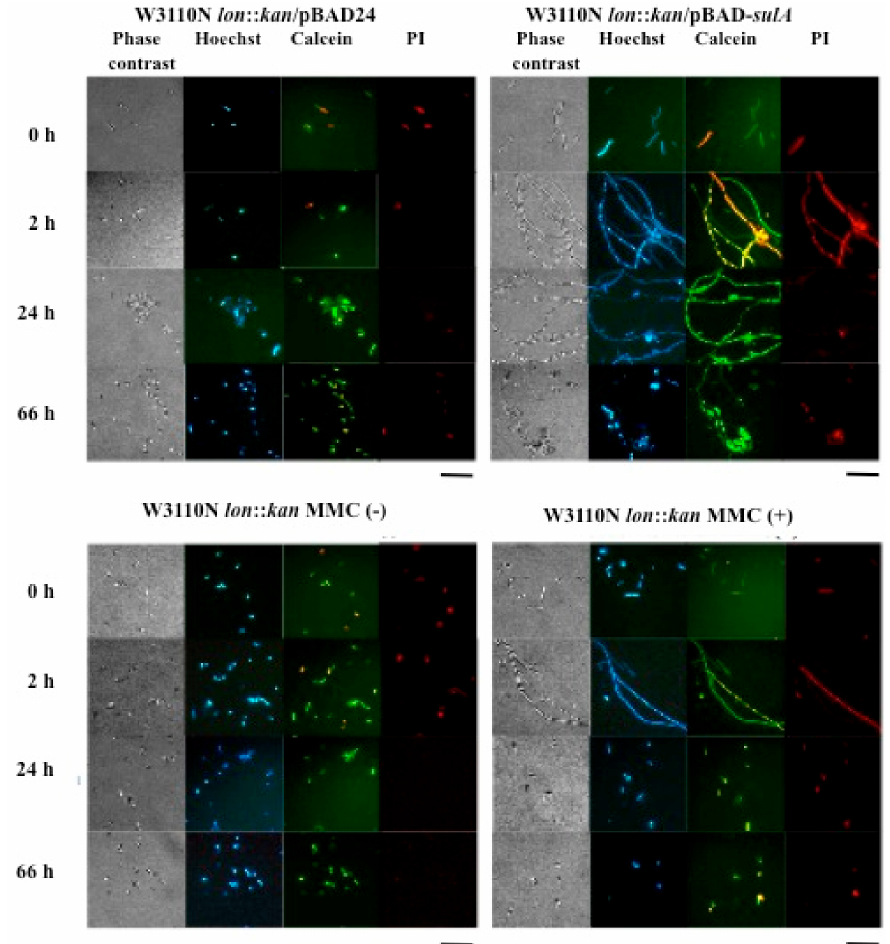
Figure 2. Morphological observation and live/dead staining of cells grown under the condition with MMC or with overexpression of sulA . W3110N lon :: kan cells were grown in LB medium containing kanamycin; W3110N lon :: kan cells harboring pBAD24 or pBAD- sulA were grown in LB medium containing ampicillin and kanamycin; MMC and L-arabinose were added at OD 600 of about 0.5 at the final concentrations of 0.1 µ g/mL and 0.1%, respectively. Microscopic observation of cells was performed directly at or after staining with Hoechst; Calcein-AM, or PI Bars are 10 µ